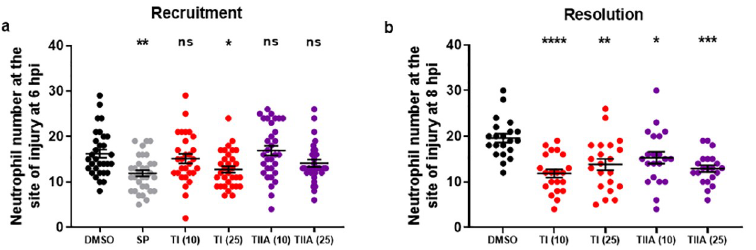
Fig 6. Effects of TI 1 and TIIA 2 on a) initial neutrophil recruitment and b) resolution of neutrophilic inflammation in a zebrafish inflammation model. For a ), tailfin transection was performed on transgenic zebrafish larvae, TgBAC(mpx : GFP)i114 (3 days post-fertilisation, dpf), which were subjected to compound treatments immediately: DMSO (0.5%), SP600125 (30 μ M) and TI 1 and TIIA 2 (10, 25 μ M as indicated in brackets). Neutrophil number at the site of injury was assessed at 6 hpi, by counting GFP+ cells. For b ), tailfin transection was performed on zebrafish larvae (3 dpf), and at 4 hpi, good responders were subjected to compound treatments: DMSO (0.5%), TI 1 and TIIA 2 (10 μ M, 25 μ M as indicated in brackets). Neutrophil number at the site of injury was assessed at 8 hpi by counting GFP+ cells. For both graphs, data shown as mean ± SEM; n = 21–32 larvae per group from 3–4 independent experiments per graph. � P < 0.05, �� P < 0.01, ��� P < 0.001, ���� P < 0.0001, compared to the DMSO vehicle control (one-way ANOVA with Dunnett’s multiple comparison